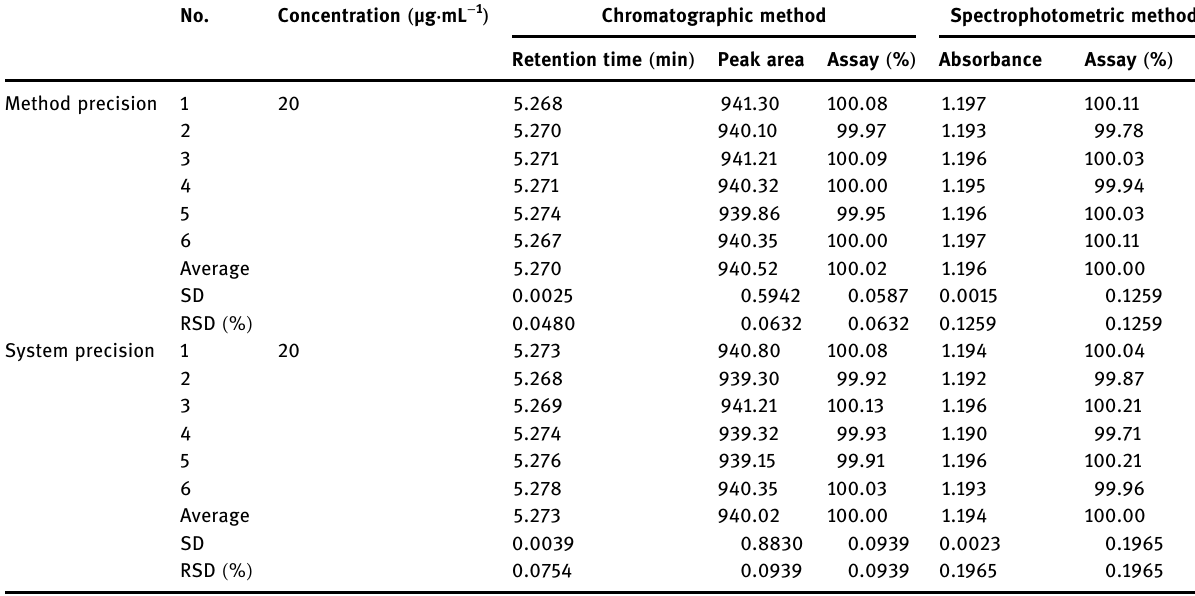
Table 3: The results of the precision study No.